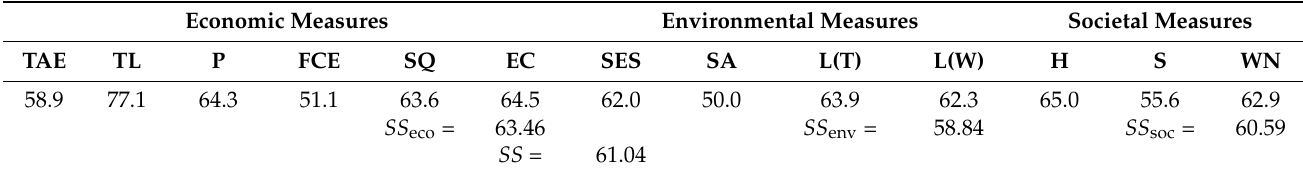
Table 6. The SS results of the example related to the drilling